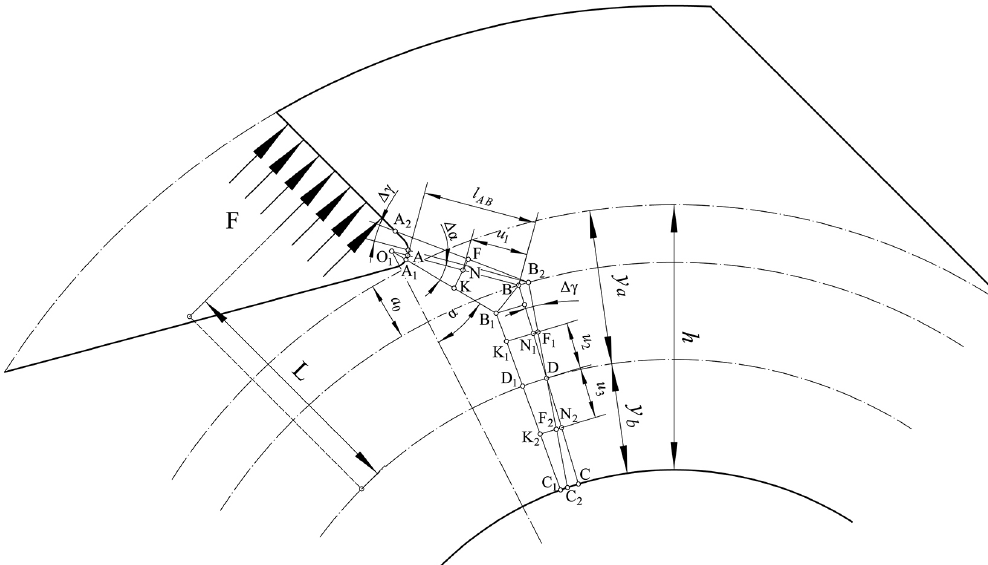
Figure 3. Deformation analysis of the polyline ABC .